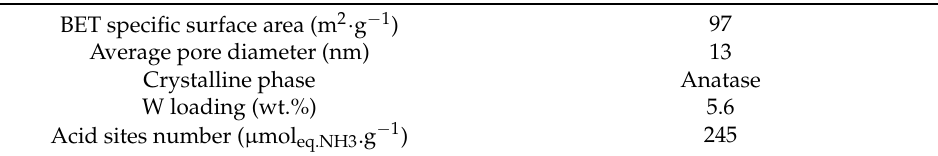
Table 4. Catalyst properties (from